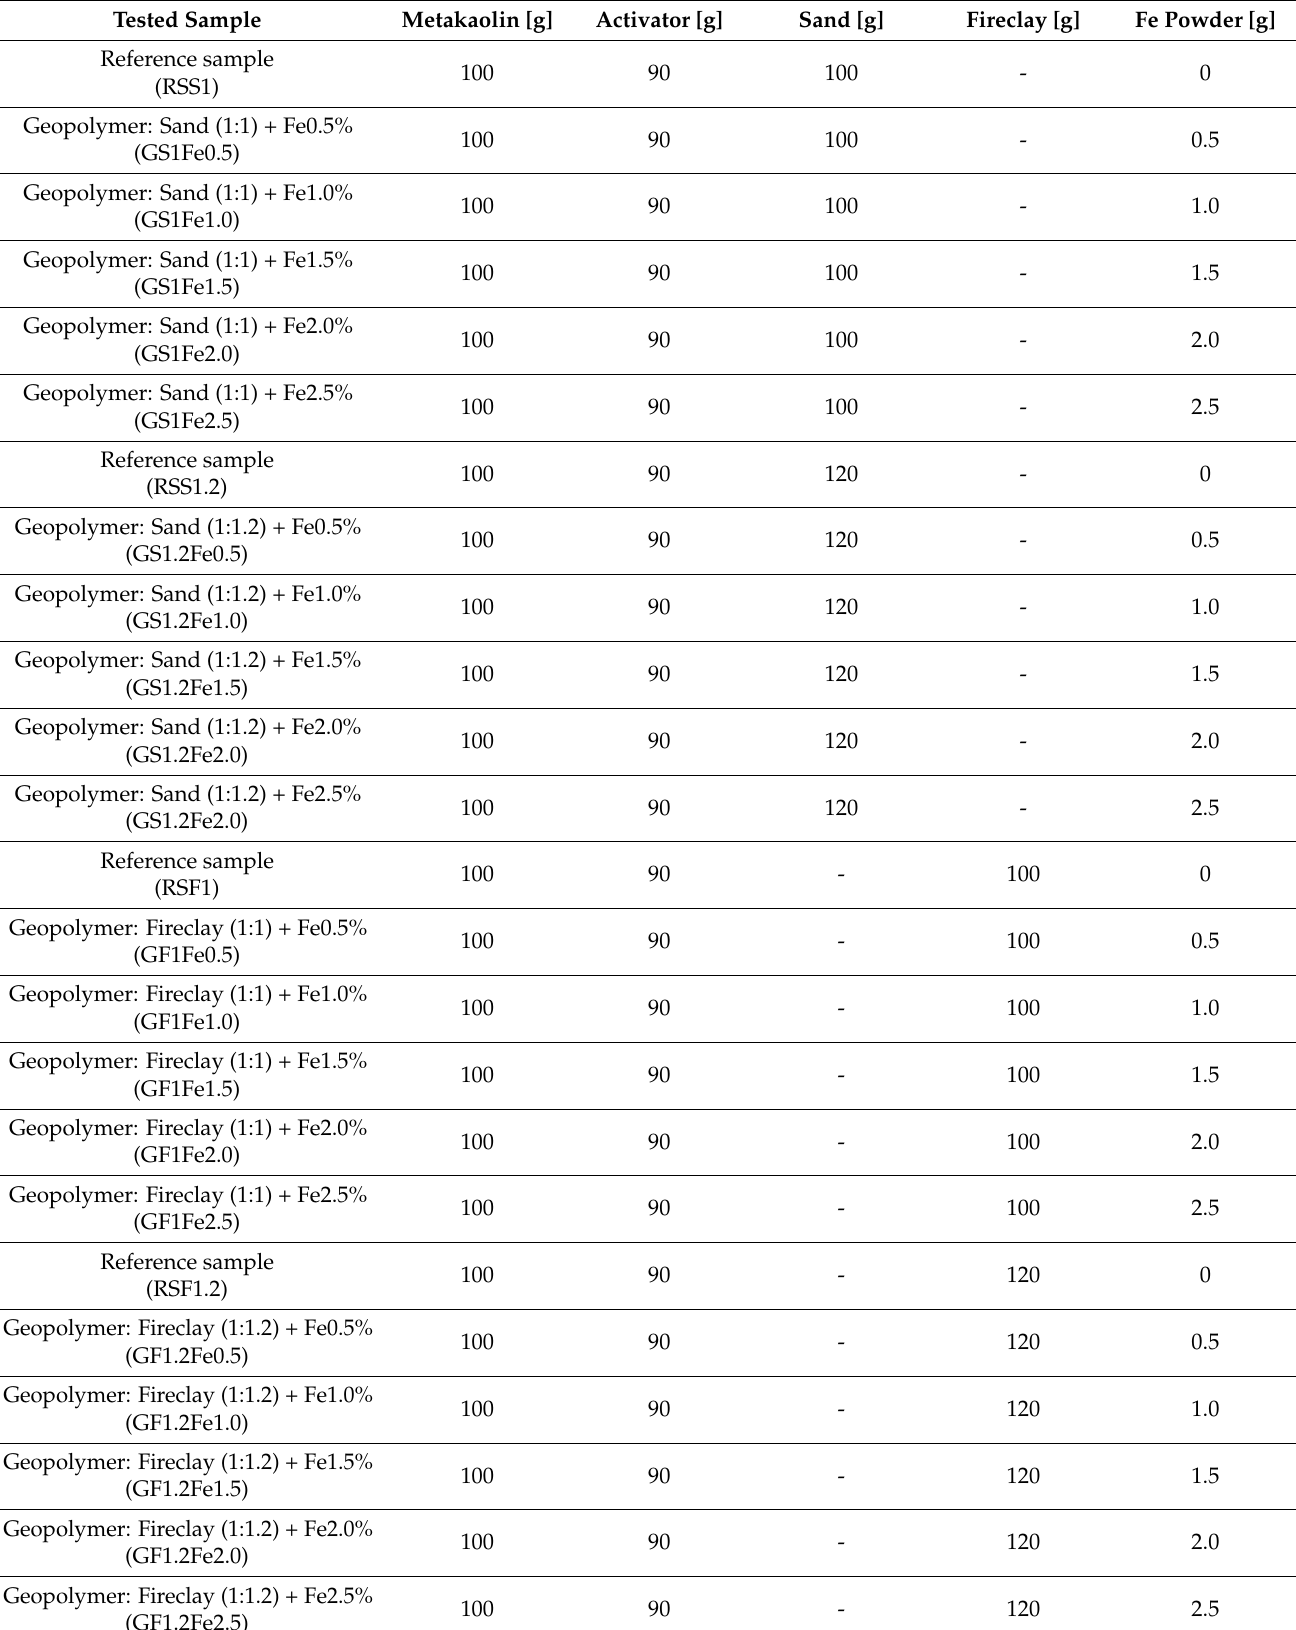
Table 1. Composition of the geopolymer pastes used in the